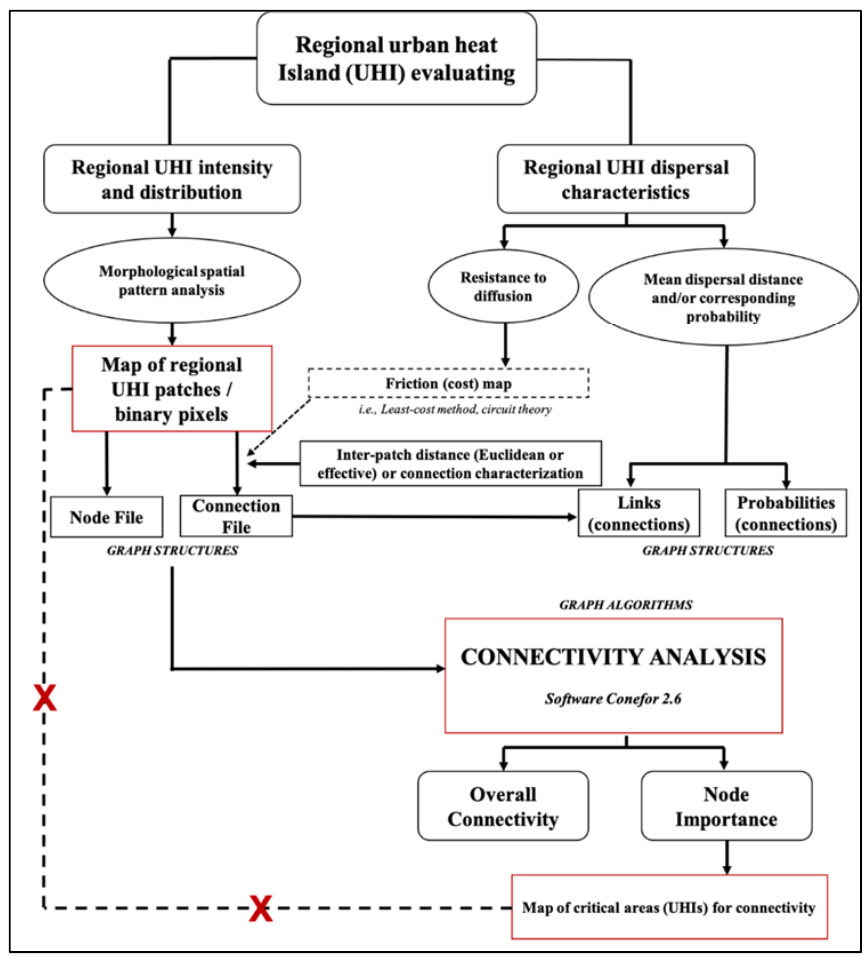
Figure 2. The framework for integrating MSPA and habitat availability indices for evaluating regional urban heat islands. Red “X” means block or destroy the connectivity of the result to alleviate the regional surface UHI